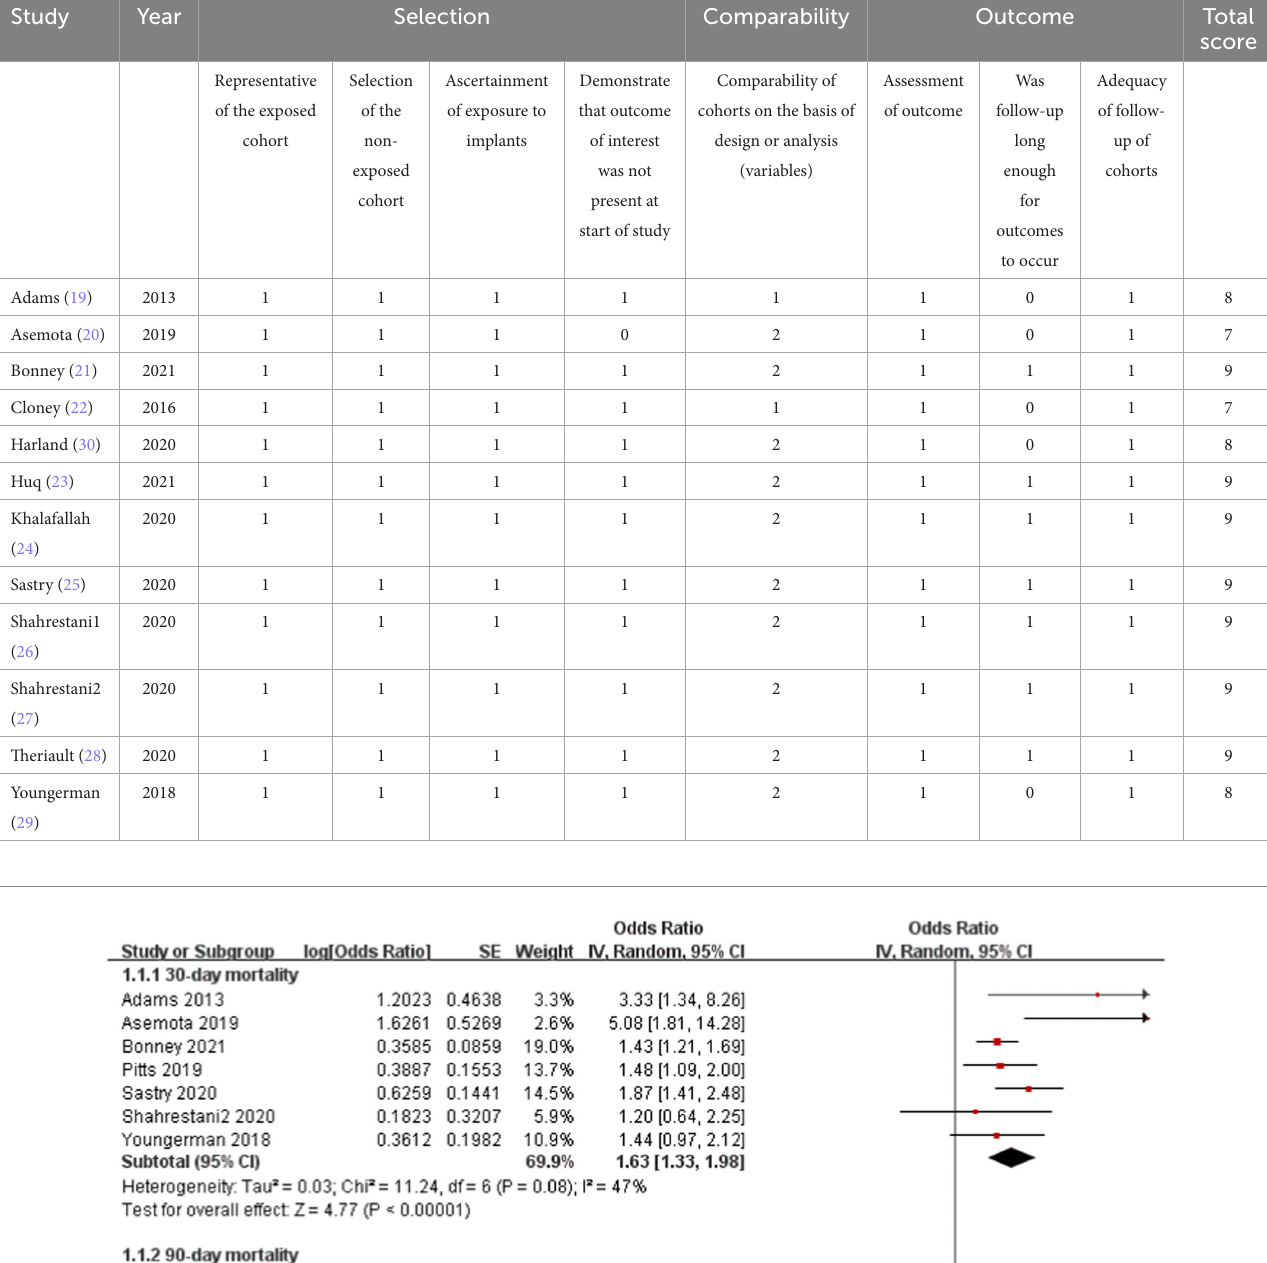
TABLE 2 Quality assessment of studies using the Newcastle-Ottawa Scale. Study